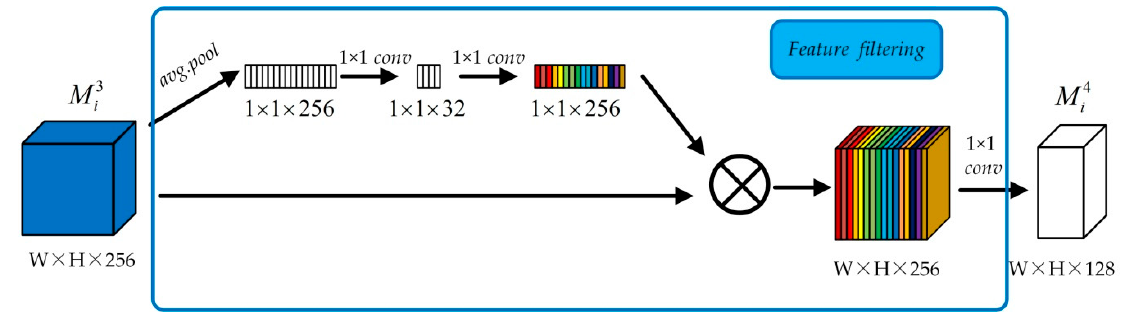
Figure 3. Diagram of feature filtering.